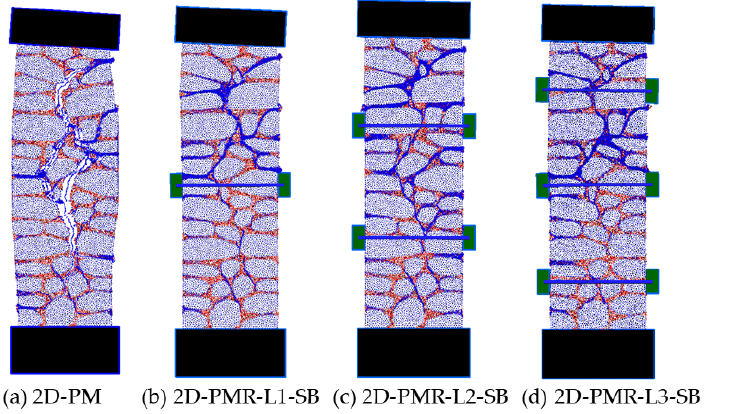
Figure 13. Numerical models: contact damage distribution with and without various reinforcement levels and a strong bond.